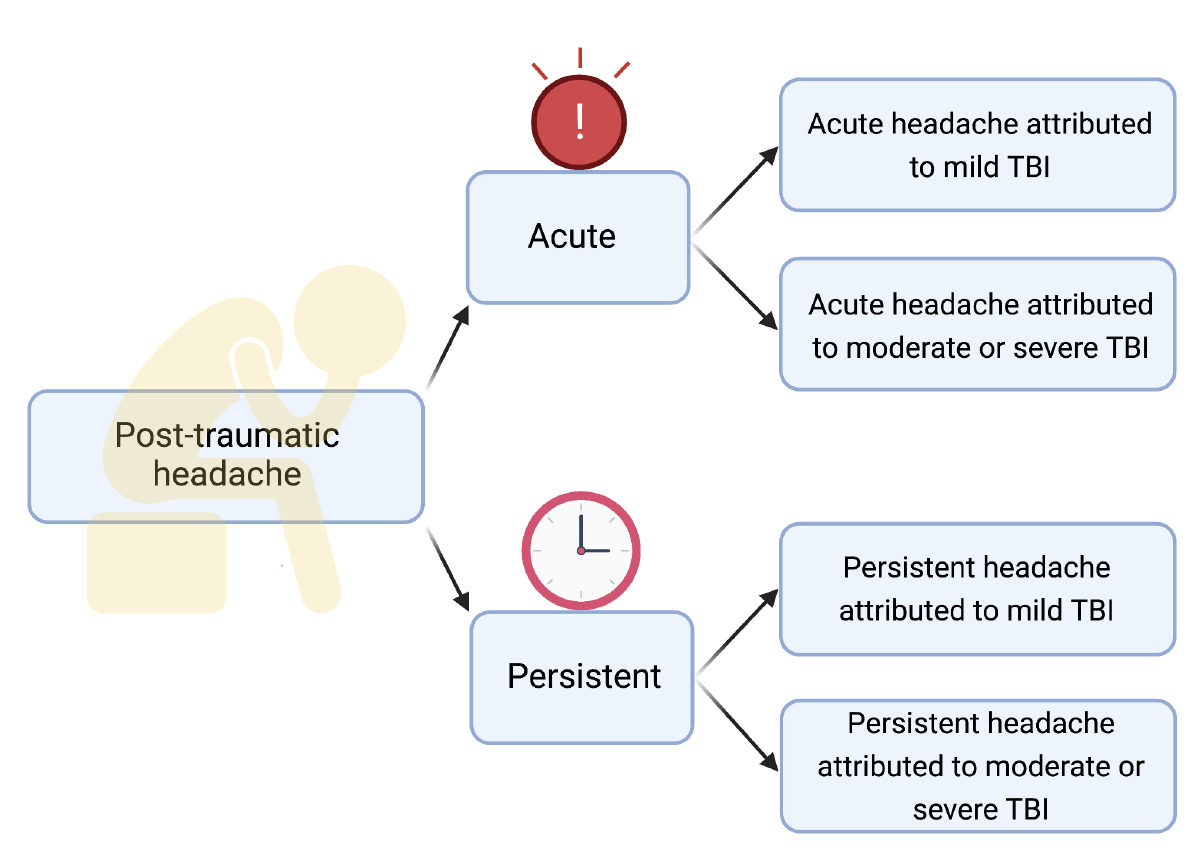
Fig. 2. Classification of acute and persistent headache according to the International Classification of Headache Disorders, 3rd version [54]. Post-traumatic headaches can be divided into acute and persistent. Each category can be subdivided into mild and